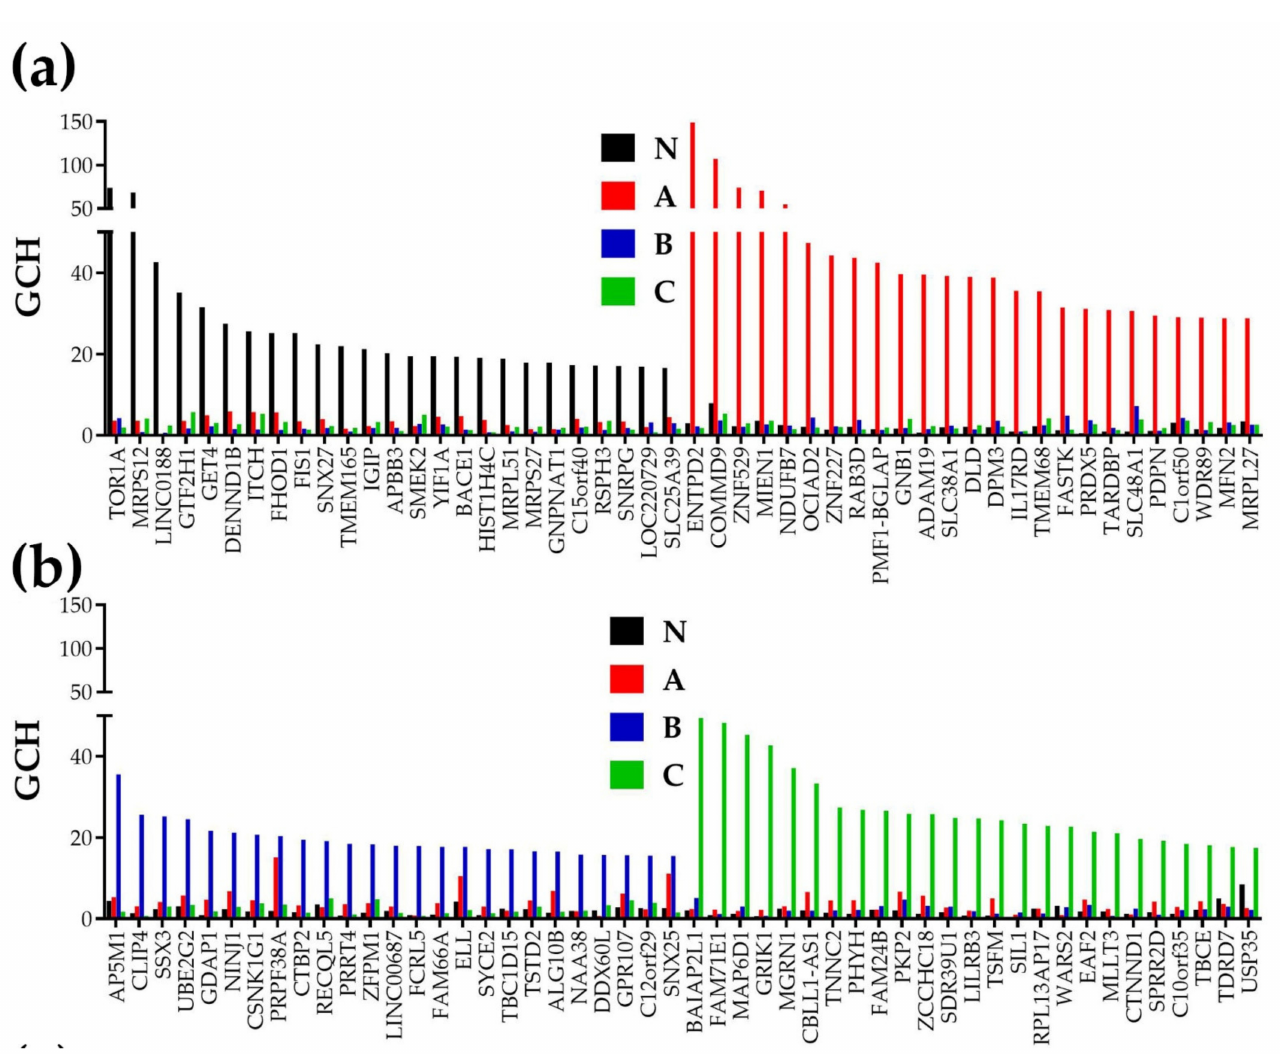
Figure 6. Top 25 genes in each region and what may happen to the regulated enzyme genes in “A” by overexpressing ENTPD2 , the GMR of “A”. ( a ) Top 25 genes in “N” and “A”; ( b ) Top 25 genes in “B” and